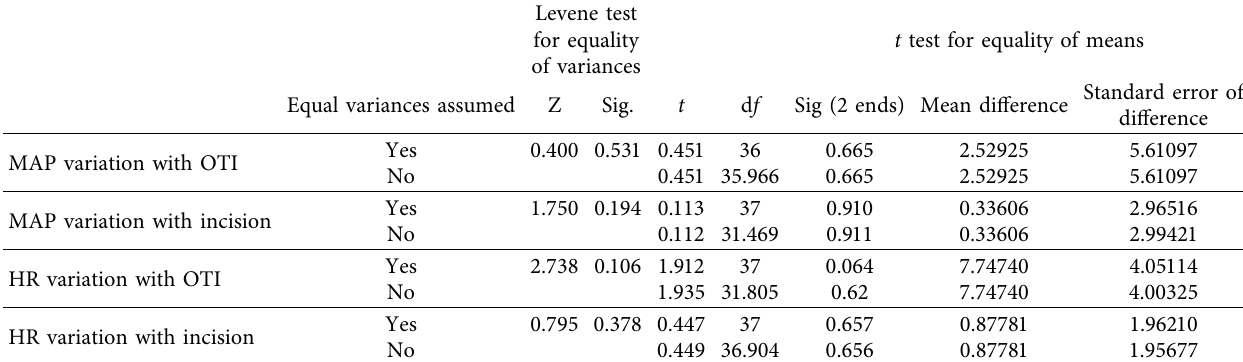
Table 3: Student’s test for difference in MAP, mean arterial pressure; HR, heart rate; OTI, orotracheal intubation.